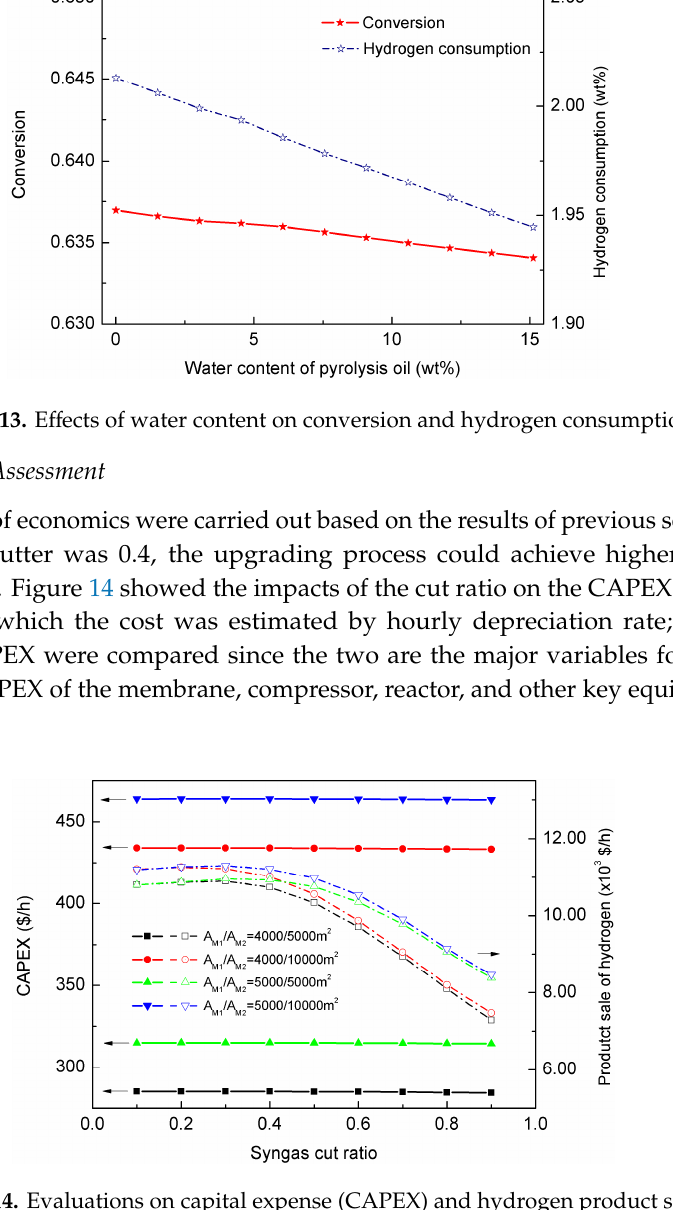
Figure 12. Effects of water–gas-shift reaction on hydrogen production.